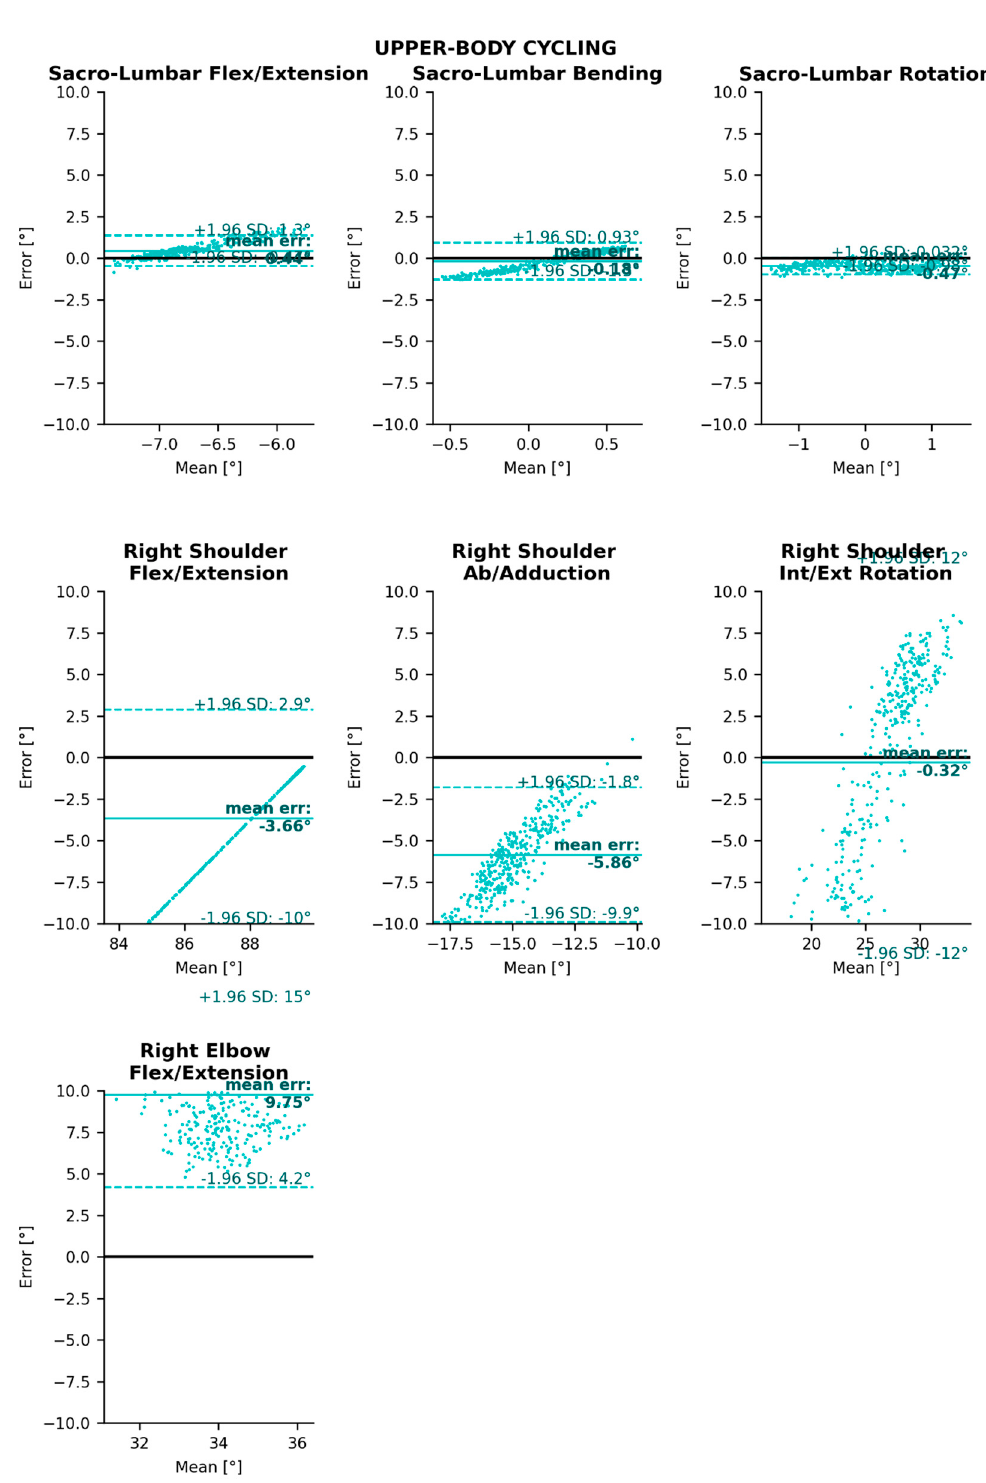
Figure A10. Bland–Altman analysis of sacro-lumbar and upper-body joint angle errors for the cycling task. Mean bias is represented as a horizontal solid, bold line, and 95% limits of agreement are represented as dotted lines.